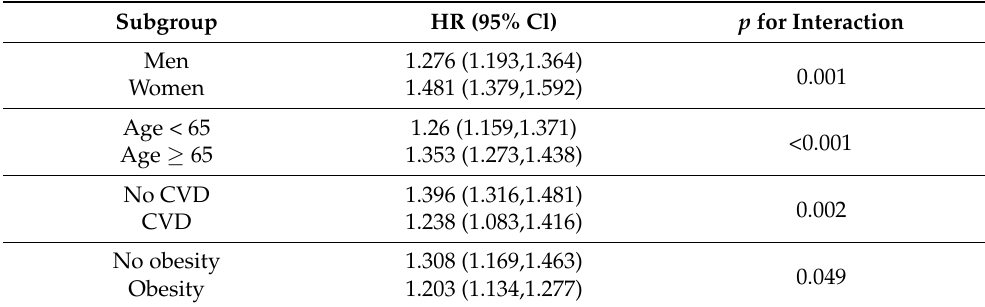
Table 3. Adjusted hazard ratios for the incidence of heart failure in the subjects with fatty liver stratified to